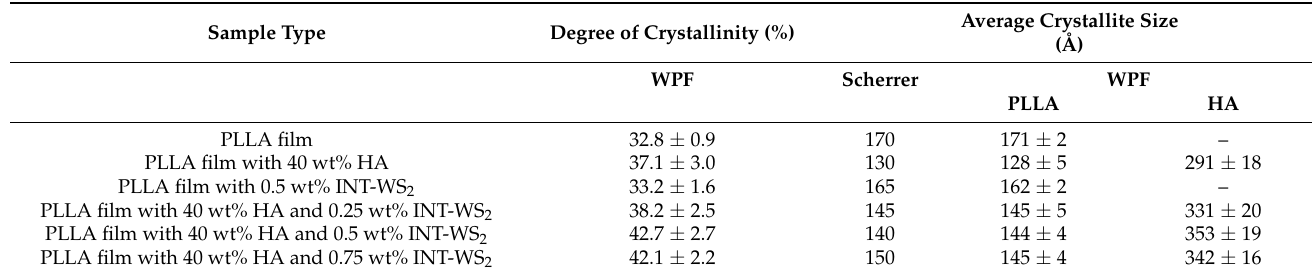
Figure 2. XRD patterns of PLLA film and HA/INT-WS 2 /PLLA nanocomposites. Table 1. The degree of crystallinity of PLLA film and HA/INT-WS 2 /PLLA nanocomposites. Sample